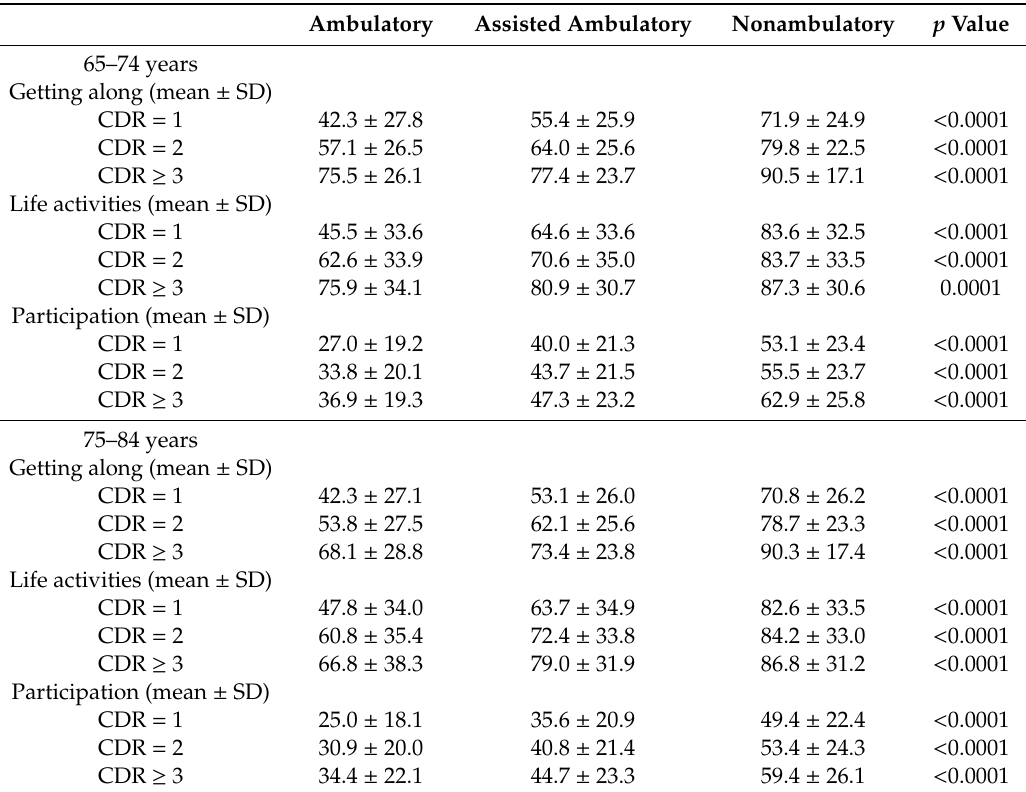
Table A1. WHODAS 2.0 scores of participants with di ff erent ambulatory status and Clinical Dementia Rating in the three age